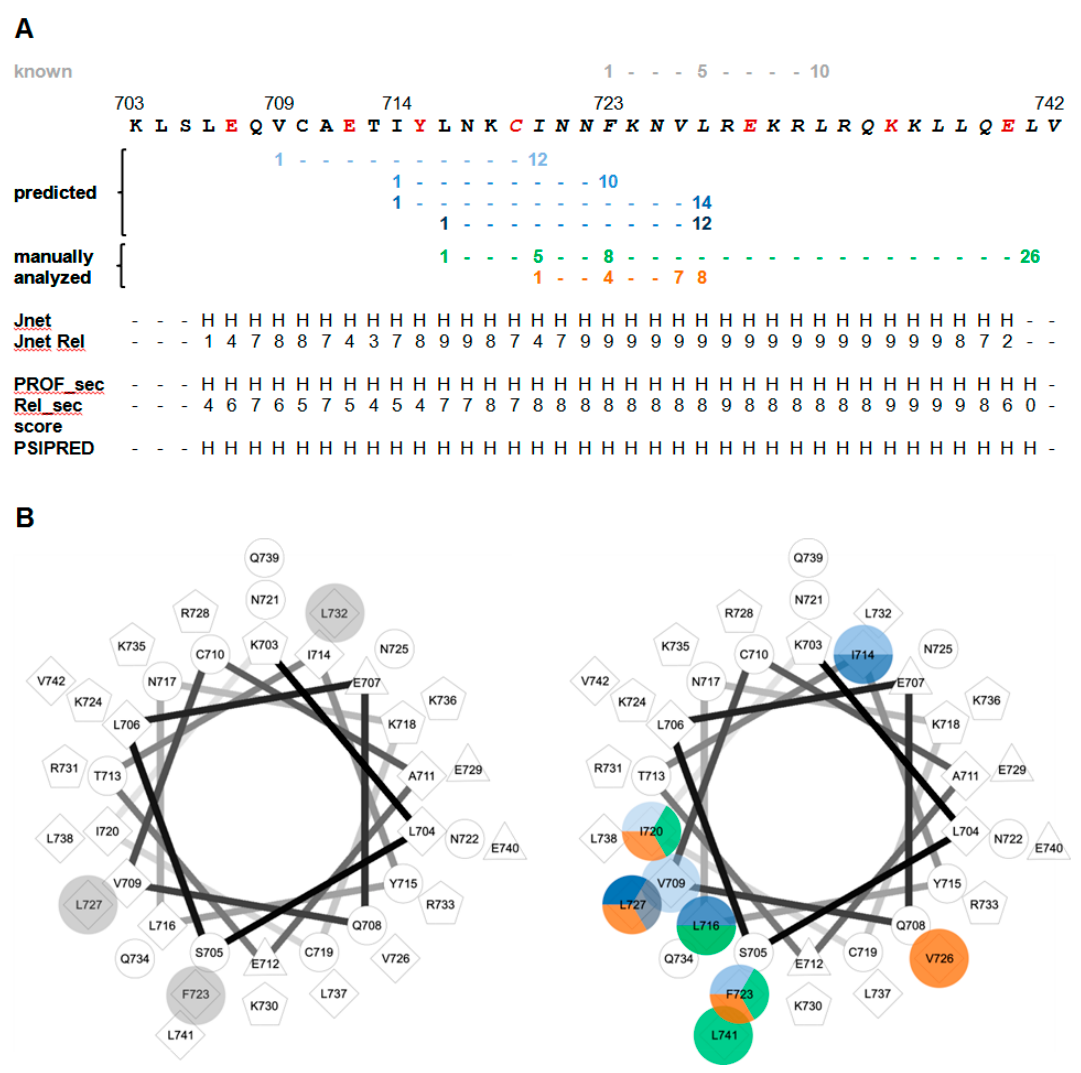
Figure 8. Analysis of potential binding motifs in bMunc13-2 segment-C. Only CaM binding motifs starting N -terminally to position 1 of the proposed 1 ‒ 5 ‒ 10 binding motif were analyzed. The known 1 ‒ 5 ‒ 10 CaM binding motif is colored in gray, CaM binding motifs identified by database comparison are shown in different shades of blue, manually identified CaM binding motifs are colored green and orange. ( A ) Amino acid sequence, predicted CaM binding motifs and secondary structure prediction of segment-C. Amino acids identified in cross-linking studies are highlighted in red. Three different prediction servers were used: Jpred (www.compbio.dundee.ac.uk / jpred), PredictProtein (www. predictprotein.org), and PSIPRED (bioinf.cs.ucl.ac.uk / psipred). The algorithms Jnet and PROF_sec provide a score for α -helical propensity between 0 (lowest propensity) and 9 (highest propensity). H, predicted to be α -helical. ( B ) Helical wheel projection of segment-C. The known CaM binding motif is displayed on the left; novel CaM binding motifs are highlighted on the